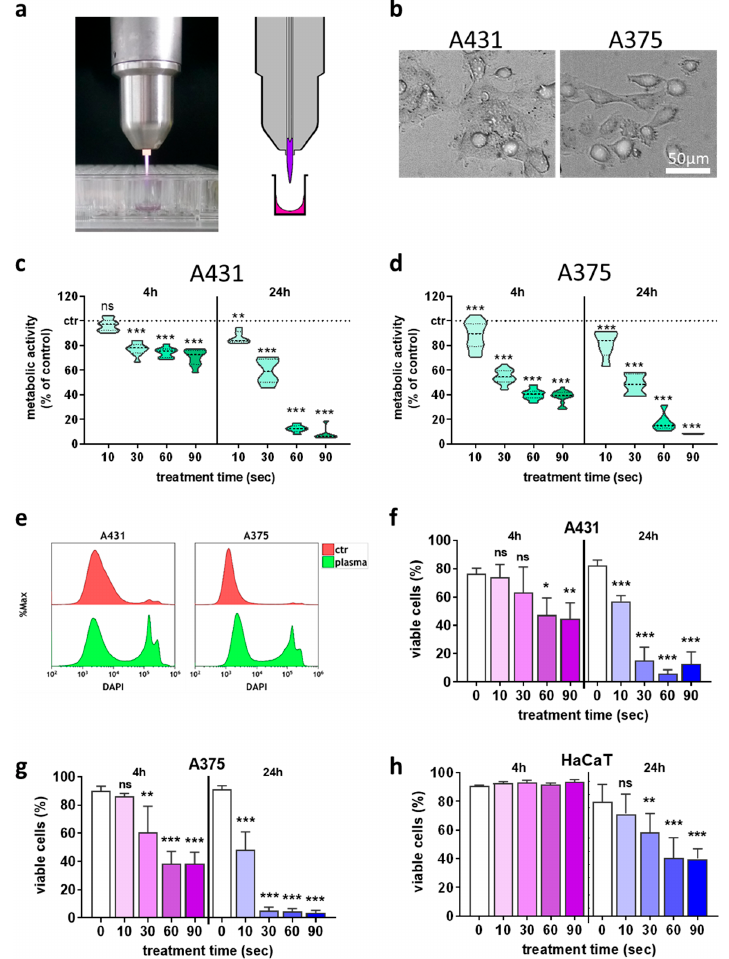
Figure 1. Plasma treatment inactivated skin cancer cells in a treatment time-dependent fashion. ( a ) atmospheric pressure argon plasma jet kINPen; ( b ) representative brightfield image of the two cancer cell types used in this study; ( c , d ) normalized metabolic activity 4 h and 24 h after plasma treatment in A431 ( c ) and A375 ( d ) cells; ( e ) representative overlay flow cytometry histograms of the terminal cell death dye DAPI in cells with and without plasma treatment at 24 h; ( f – h ) quantification of viable A431 ( f ), A375 ( g ), and HaCaT ( h ) cells using flow cytometry. Data are the mean of three independent experiments. Statistical analysis was performed using one-way ANOVA (* = p < 0.01, ** = p < 0.01, *** = p < 0.001). ns = not significant, ctr =